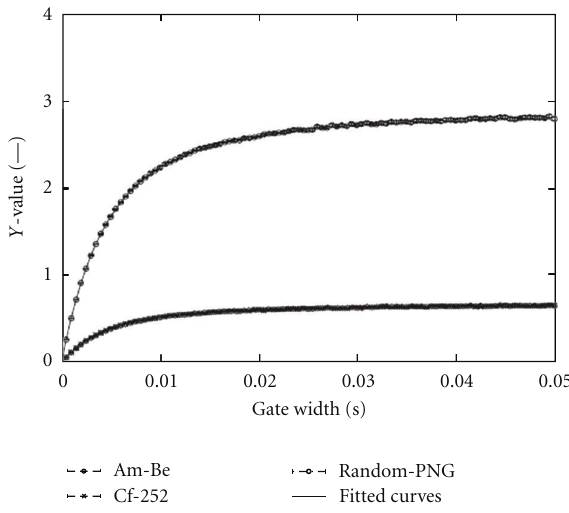
Figure 1: Feynman- α curves measured with di ff erent neutron sources